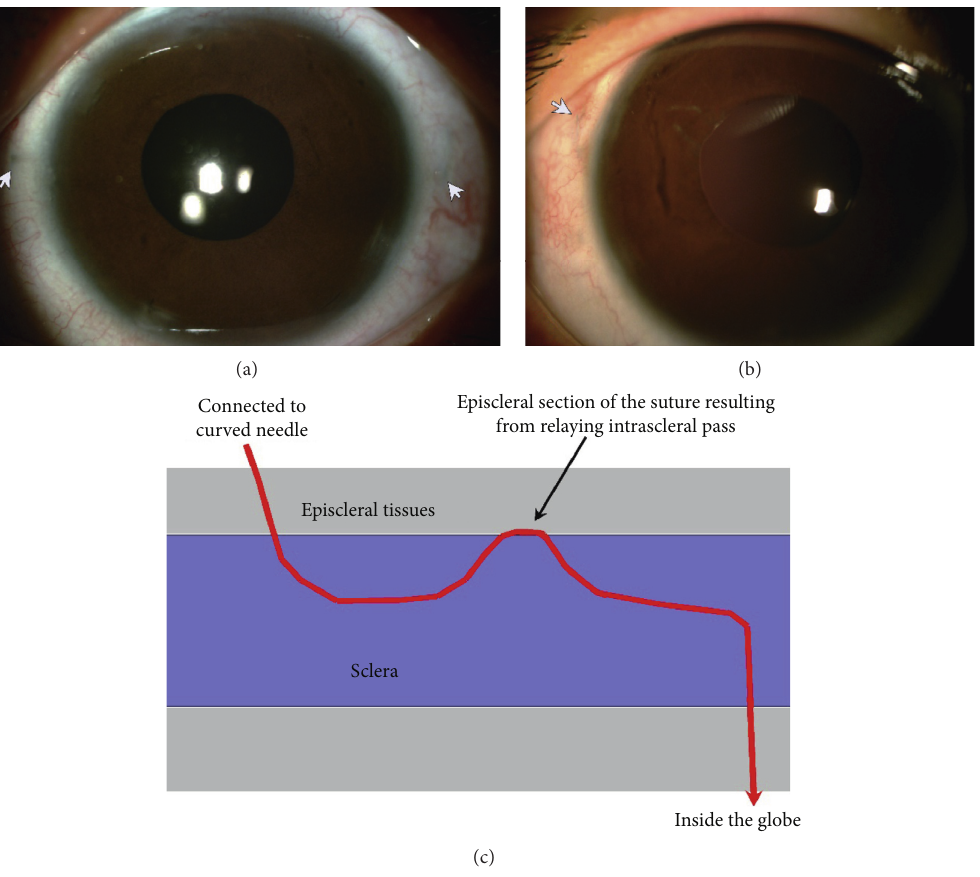
Figure 2: Postoperative overviews. There was barely conjunctival and scleral scarring after surgery. Only very short sections of the thread (arrows) resulting from the relaying intrascleral pass can be observed under the episcleral tissue in some of the cases. This phenomenon is identical to the turning point of the Z -suture